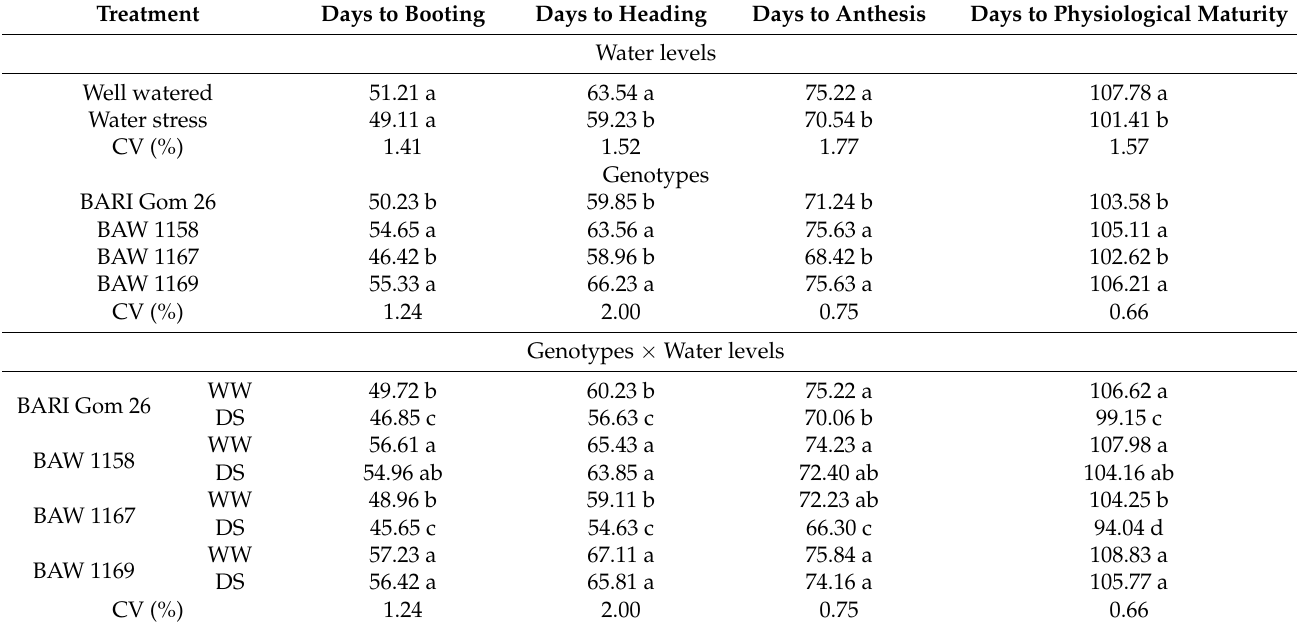
Table 5. Effect of DS on days required to attain different phenophases in different wheat genotypes.